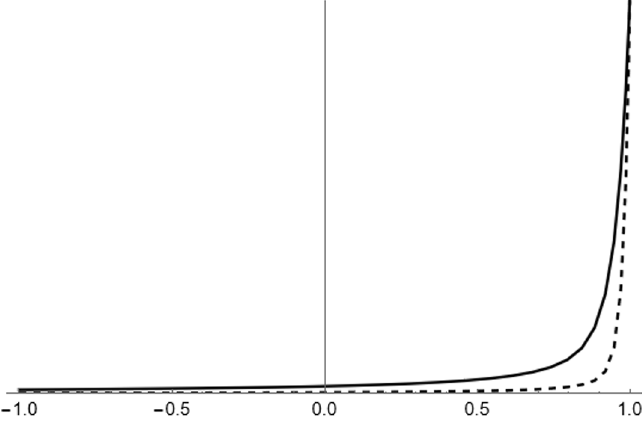
Figure 7 . Comparison of the diagrams (4.39) — solid, and (4.24) — dashed. We show the contribution without the scalar product of the external coherent states and the g/ 4! factors. The horizontal axis shows u = cos ϑ again and we rescale the expressions such that they have the same value for ϑ = 0 . The plot is for the value N = 120